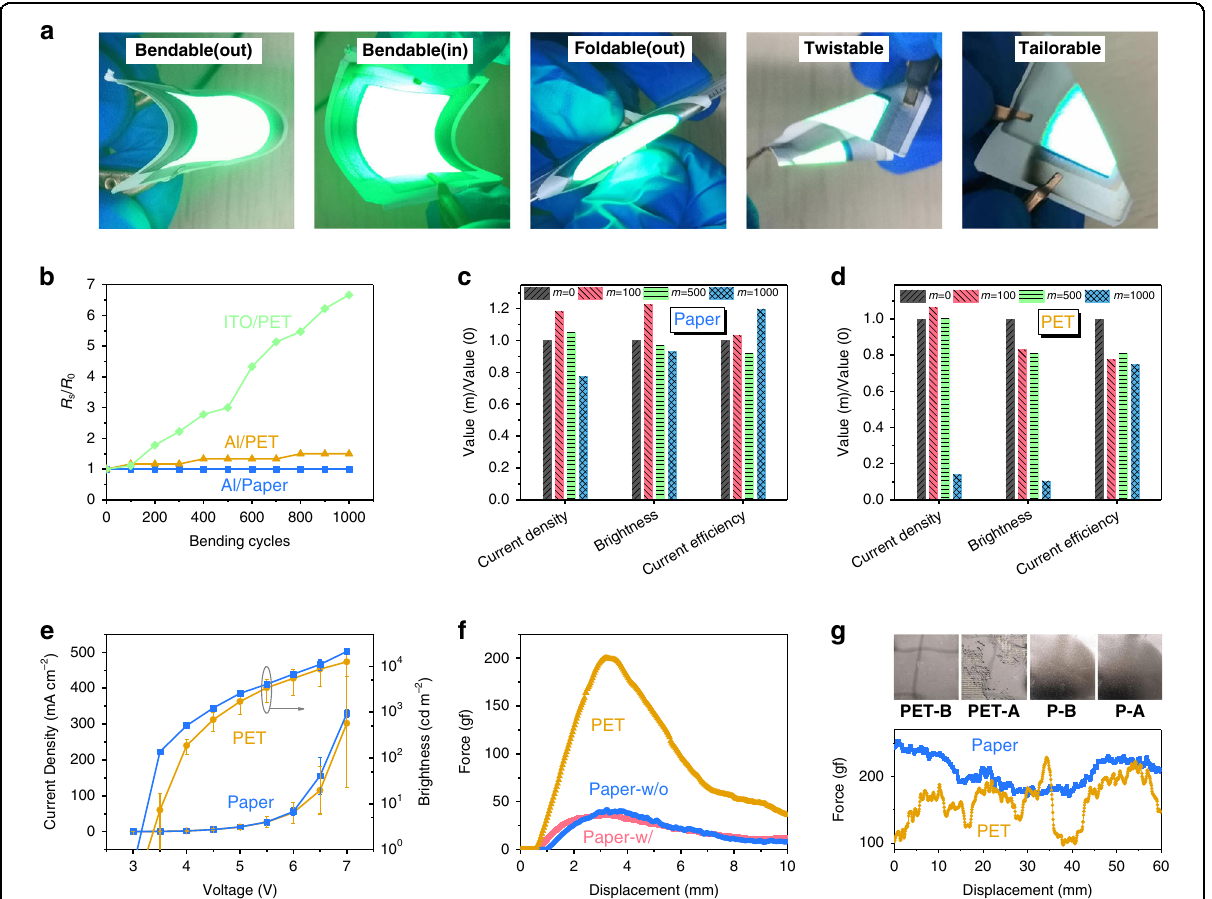
Fig. 3 Mechanical properties of substrates and devices. a Images of paper-based green OLEDs after being bent, folded, twisted, and cut in half. b Current density – voltage – brightness of “ TG-P ” and “ TG-PET ” at different bending cycles and the variance. c , d Variations of current density, brightness, and current ef fi ciency of devices ( c ) “ TG-P ” and ( d ) “ TG-PET ” before and after bending, and the value (m) represents the corresponding value of the device characteristics after bending m times. e Sheet resistance of the Al electrode based on stone paper, PET, and PET/ITO at different bending cycles. f Force-de fl ection characteristics of stone-paper substrates with (Paper-w/) and without (Paper-w/o) dip-coating treatments and PET substrates. g (upper row) Top-view images of the Al electrodes before and after peel tests, and (bottom row) peeling force – displacement characteristics of Al electrodes (100 nm) coated on paper and PET